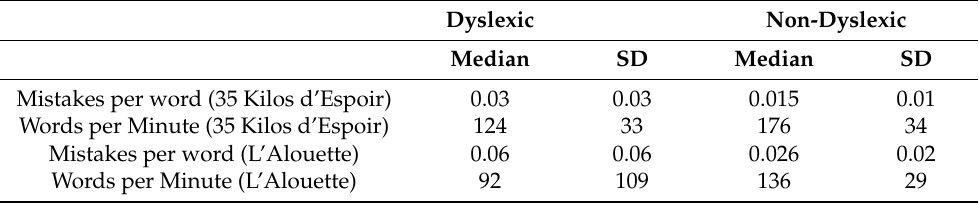
Table 1. Dyslexic vs. Non-Dyslexic performance for each reading